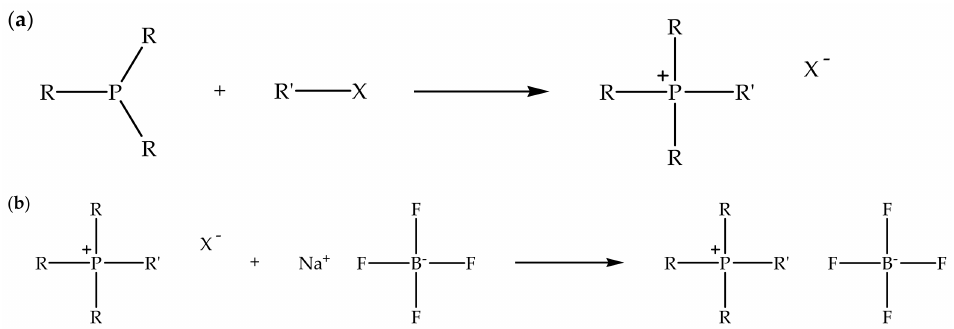
Figure 4. Schematic of the ( a ) alkylation and ( b ) metathesis reactions for synthesis of alkylphosph- onium-based ionic liquids. Table 5. Types of alkylphosphonium-based ionic liquids, fillers, polymer matrices, and fabrication processes of biodegradable polymer